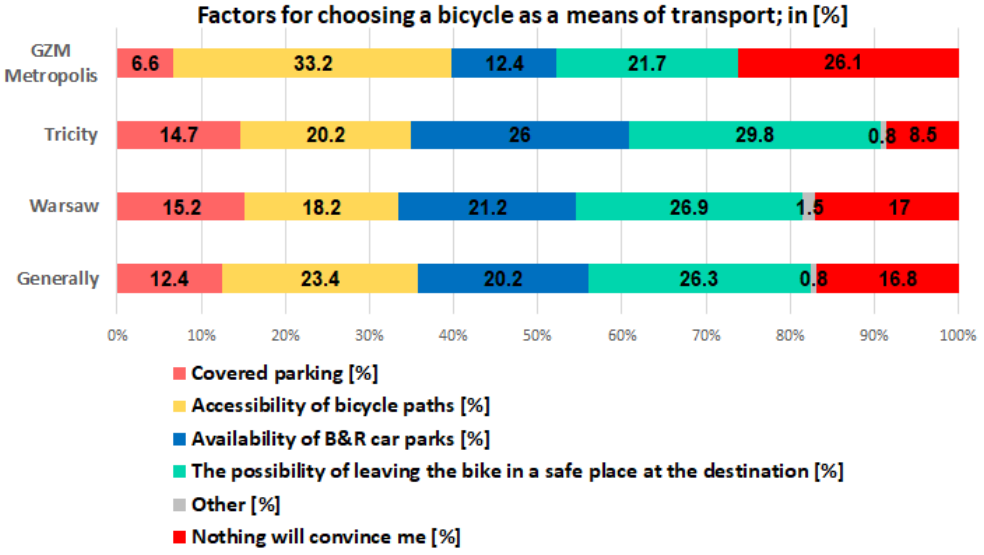
Figure 4. Factors for choosing a bicycle as a means of transport. Source: based on